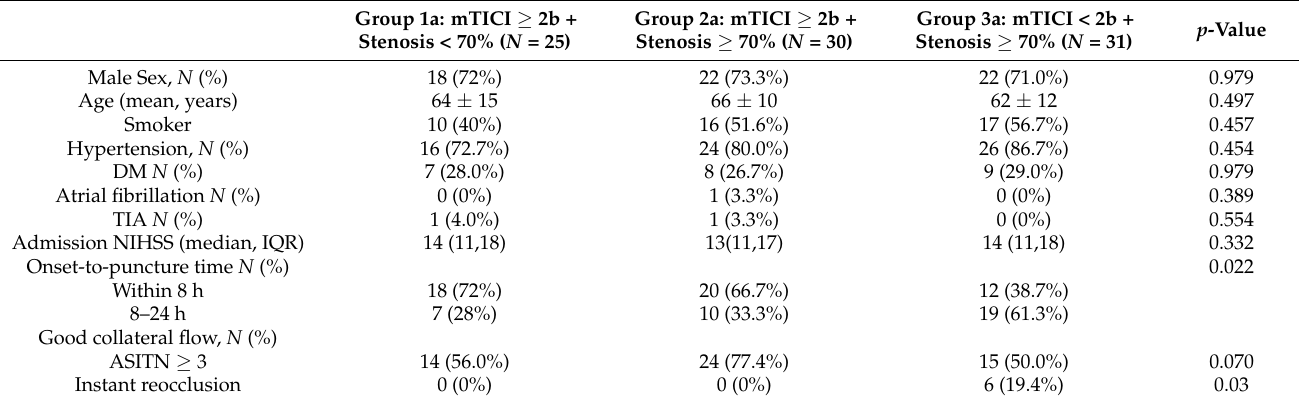
Table 1. Baseline characteristics and clinical outcomes of patients in Step 1 of the